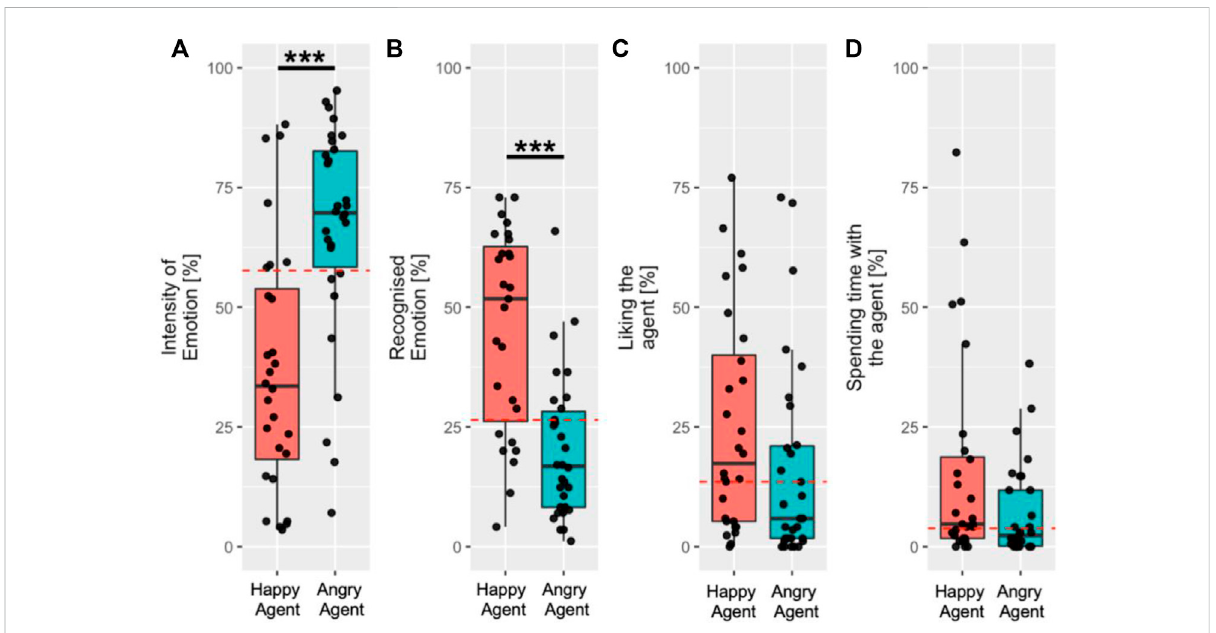
FIGURE 3 Results of post hoc analyses of post-experientially assessed evaluation of the agent. (A) Emotional valence ( “ How positive was the emotion perceived ” : 0% = “ very negative, ” 100% = “ very positive ” ), (B) emotional intensity ( “ How intensive did the emotion of the agent appear ” : 0% = “ not intensive at all, ” 100% = “ very intensive ” ), (C) preference for theagent ( “ How muchwasthe agentliked ” : 0%= “ Ididnot likethe agent atall, ” 100% = “ I liked the agent very much ” ), and (D) social preference for the agent ( “ Would the participant spend more time with the agent ” : 0% = “ Would not like to spend any time with the agent, ” 100% = “ Would like to spend a lot of time with the agent ” ). Each point represents the rating of one participant. Horizontal lines in the boxes: median. Boxes: +/-